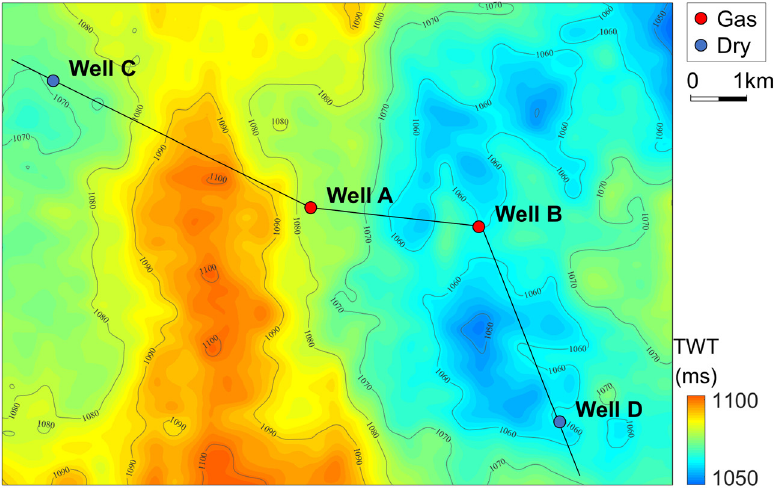
Figure 10. The two-way reflection time of the target tight sandstones. Red dots indicate gas-producing Figure 10. The two ‐ way reflection time of the target tight sandstones. Red dots indicate gas ‐ produc ‐ wells, while blue dots indicate dry wells. Black lines denote cross-well seismic ing wells, while blue dots indicate dry wells. Black lines denote cross ‐ well seismic lines.